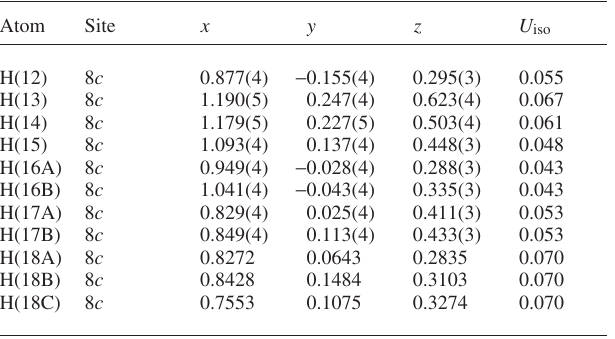
Table 2. Atomic coordinates and displacement parameters (in Å 2 )